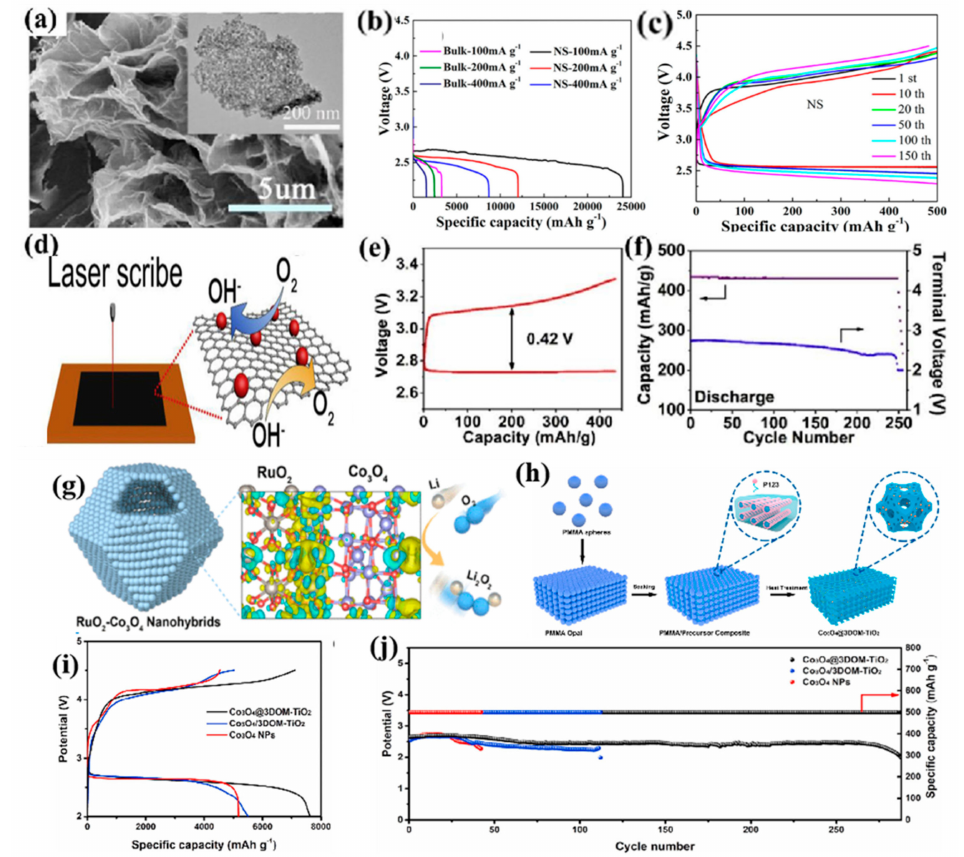
Figure 9. ( a ) SEM and TEM images of the Co 3 O 4 nanosheets. ( b ) Specific capacities for the bulk and nanosheet samples at 100, 200, and 400 mA g − 1 , respectively. ( c ) cycle performance of the Co 3 O 4 nanosheets cathodes with a fixed capacity of 500 mA h g − 1 at of 400 mA g − 1 . Reprinted